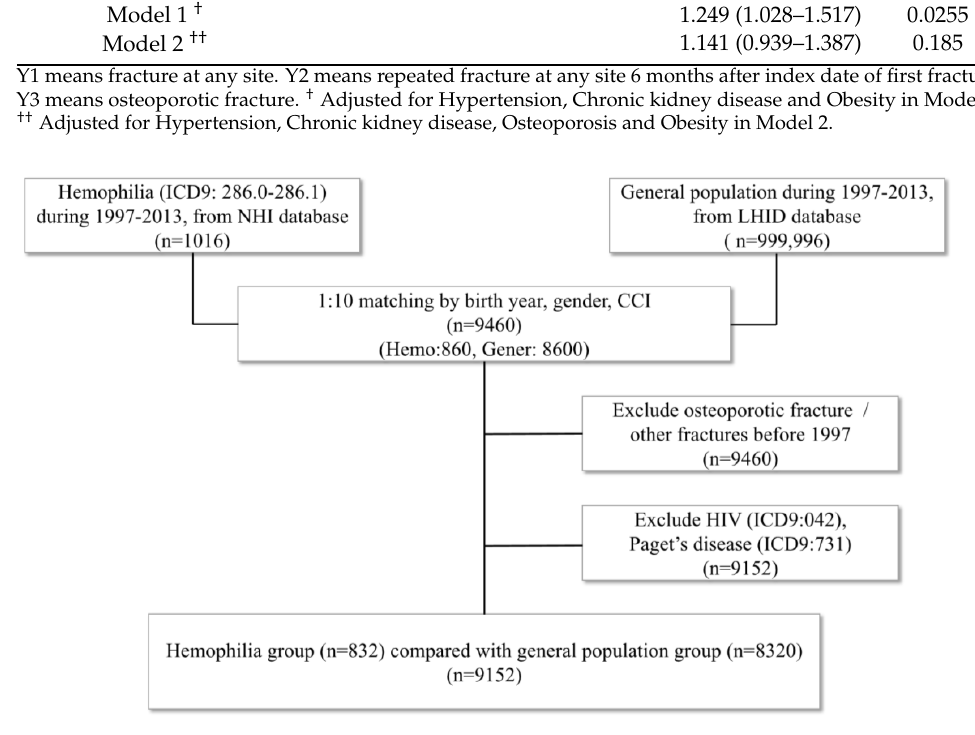
Figure 1. Flow chart of study design. (NHI = National Health Insurance; LHID = Longitudinal Health Insurance Database; CCI = Charlson Comorbidity Index; HIV = human immunodeficiency virus).